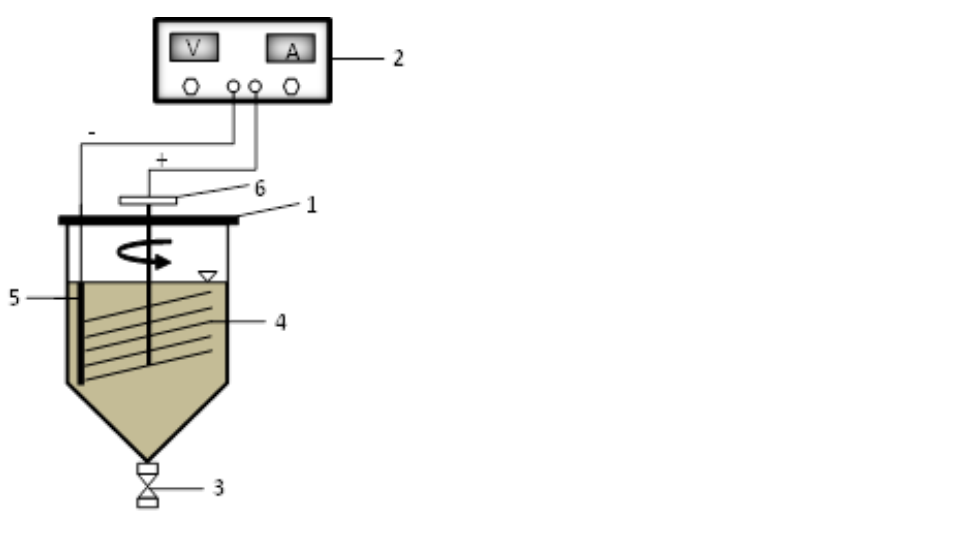
Figure 2. Scheme of SBBR experimental model [23]: 1—reactor, 2—DC power supply, 3—outflow of treated effluent, 4—cathode (biofilm-coated stainless-steel discs), 5—aluminum anode.